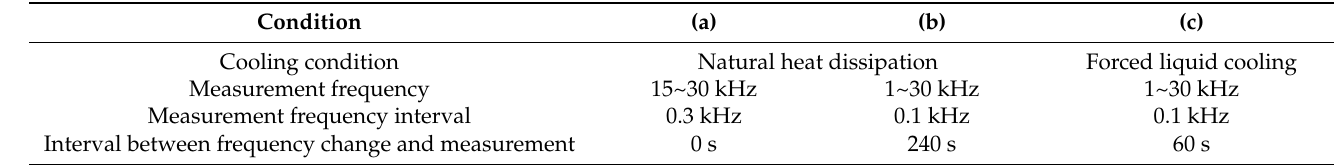
Table 4. Measurement conditions for the frequency